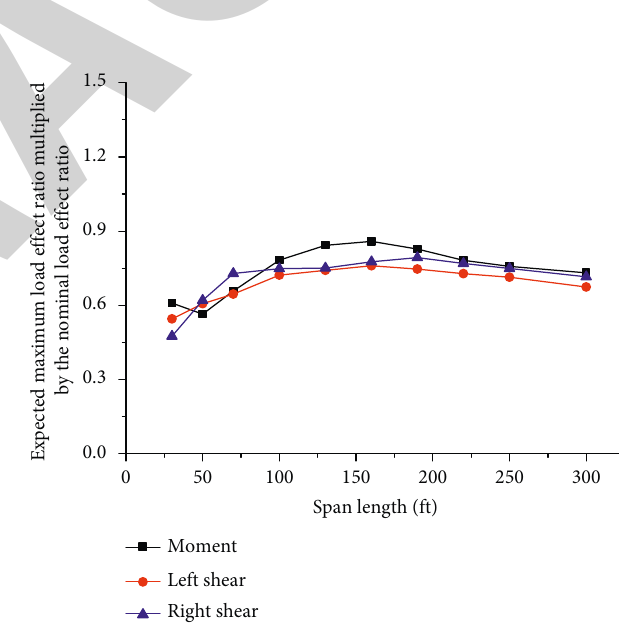
Figure 9: Expected value ratio multiplied by nominal load effect ratio in equation (8) for site 002 (with 20%